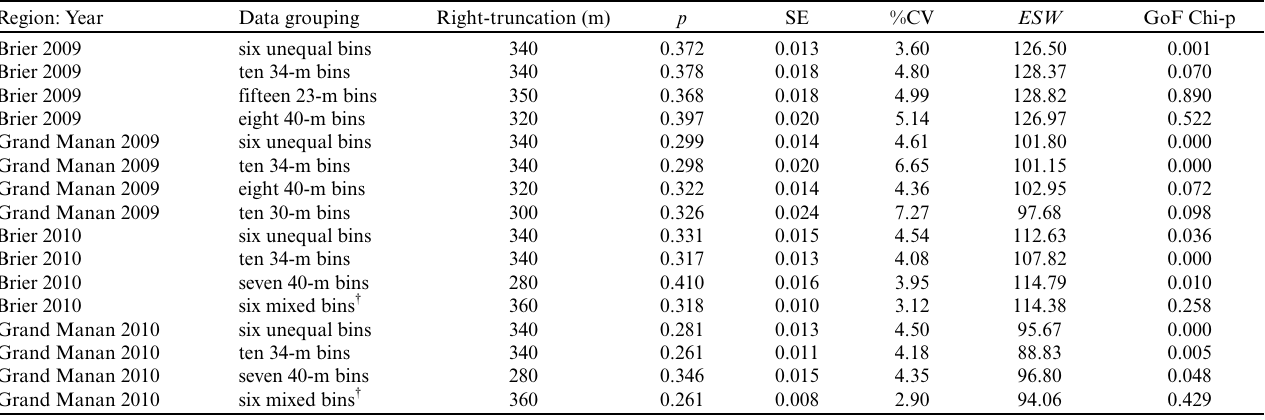
Table 1 . Parameter estimates ( p, ESW ) for detectability of phalarope flocks from detection functions fitted with various data groupings. Global detection functions were fitted to data pooled across survey dates at four levels (region:yr). All models used a half-normal key with simple polynomial or cosine adjustment terms. For each model, p refers to the estimated average detection probability and ESW refers to the effective strip width. Standard error (SE) and %CV are reported for p . The chosen data grouping for each of the four models was ranked by highest Chi- p values and on basis of fit at the left-edge of the detection curve.